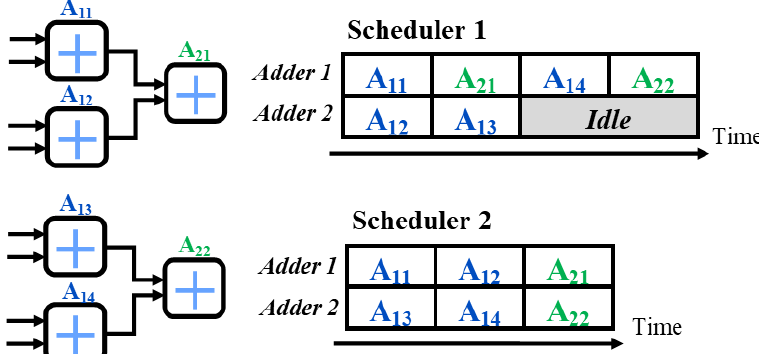
Figure 5. An illustration of different resource sharing policies, when two adders are shared between two neurons with a total of 6 needed additions. The first scheduler prioritizes the first neuron which results in an additional delay due to dependencies. The second approach prioritizes all of the neurons equally, leading to a more efficient resource sharing policy.